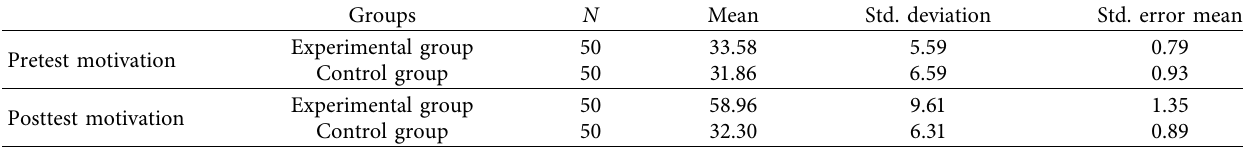
Table 3: Results of descriptive statistics for the pretest motivation and posttest motivation.